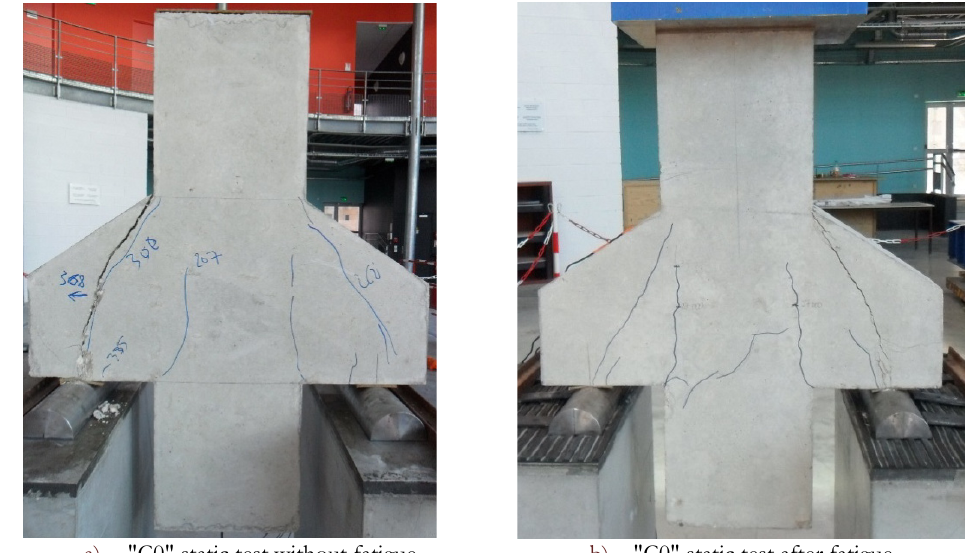
Figure 7: Cracking and failure of reinforced concrete corbel: a) C0 - static loading to failure, b) C0 fatigue - after one million cycles of unreinforced concrete